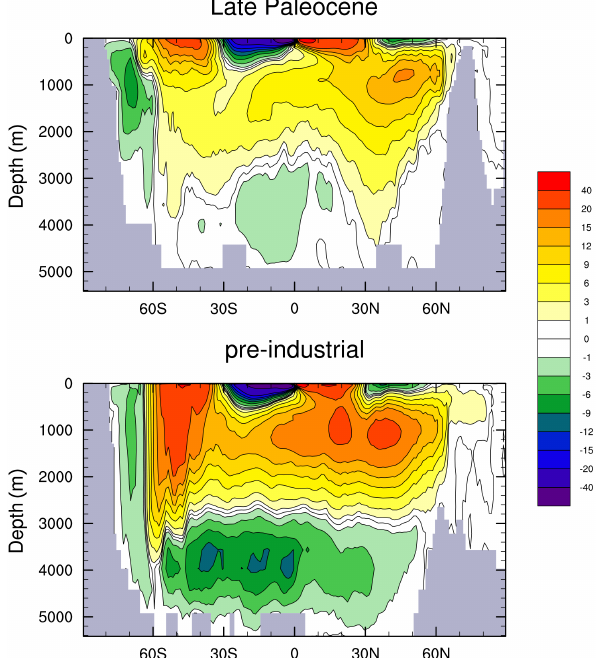
Fig. 4. Globally averaged meridional overturning circulation (Sv), for the Late Paleocene (top) and the pre- industrial (bottom). Positive values corresponds to clockwise circulation. Pre-industrial values were calculated within CMIP5 experiments.